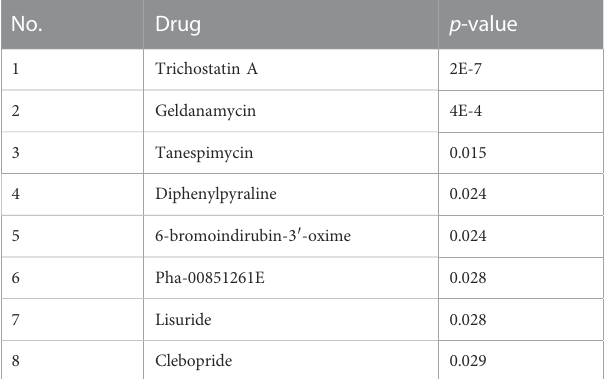
TABLE 3 Candidate NAFLD drugs identi fi ed by Connectivity Map. No.